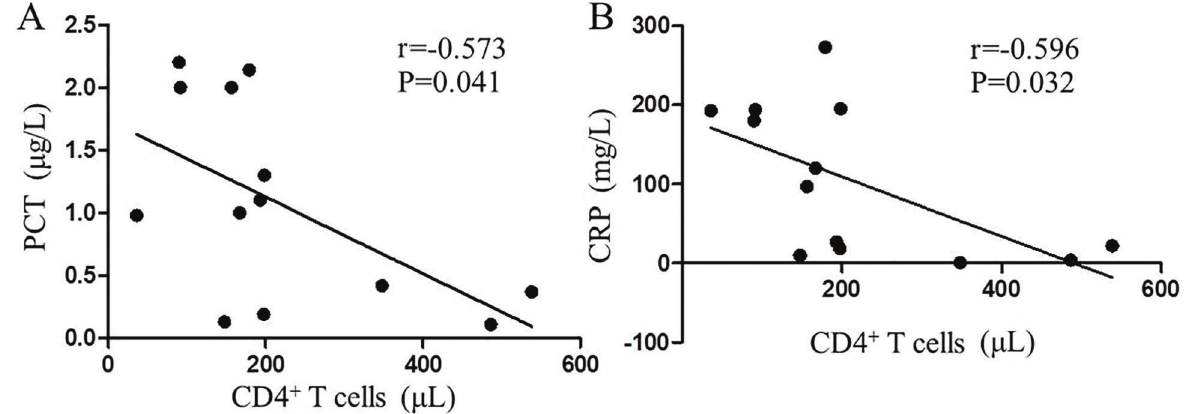
Figure 2. Associations of peripheral CD4 + T cells with ( A ) procalcitonin (PCT) and ( B ) C-reactive protein (CRP) in infectious systemic lupus erythematosus (SLE) patients. Data are reported as absolute number of peripheral CD4 + Tcells ( m L). Pearson correlation analysis was used for statistical